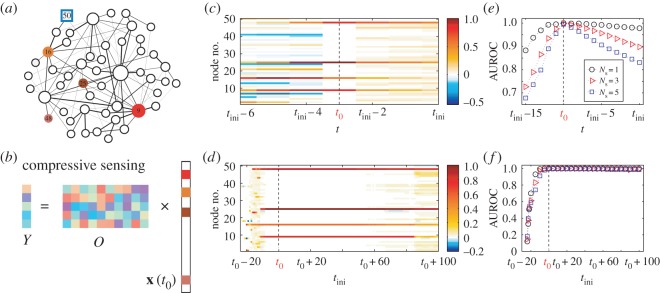
An example of locating sources in undirected weighted SF networks. (a) Illustration of an SF network with four sources with colours representing the initial state values. One messenger node is specified as a blue square. The thickness of the links represents their weight and the sizes of the nodes indicate their degrees. (b) The form of Y=Ox(t0) and the sparse initial state vector x(t0) to be reconstructed by using compressive sensing from a relatively small amount of data. (c) Reconstructed state xi(t) of each node for t≤tini, where the initial observation time is tini (tini≥t0). Colours represent the values of xi(t) with t≤tini. (d) Reconstructed initial state xi(t0) of each node from different initial observation time tini when t0, the true triggering time, is being successfully inferred. Colours represent the reconstructed values of xi(t0). The colours have the same meanings as those in (a). The four sources are randomly selected and their xi(t0) values are larger than zero. (e) Area under a receiver operating characteristic (AUROC) as a function of t (t≤tini) for a fixed initial observation time tini. (f) AUROC versus t for different initial observation time tini and different number of sources (Ns). Network parameters are set as follows. Network size is N=50, the average degree is 〈k〉=4, and the random link weights are selected from a uniform distribution in the range (0,2). For the diffusion dynamics, we set the diffusion parameter to be β=0.05 and the initial state of sources in x(t0) is randomly selected from a uniform distribution in the range (0.1,1). To implement the source localization process, the parameters are: noise amplitude σ=0, data=0.5, and the results are obtained by averaging over 300 independent simulations.